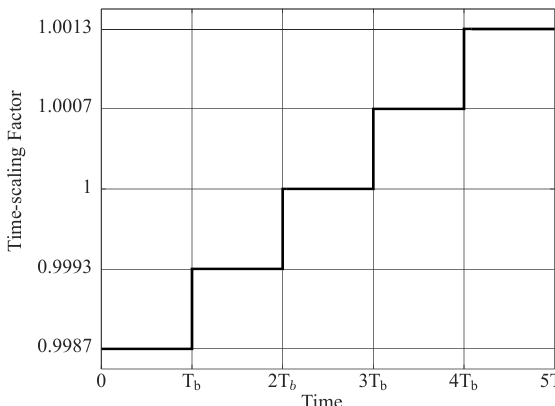
Figure 5. Step-like time-varying time-scaling function. The relative velocity during each OFDM block remains constant and it is changing from one block to the next. The vector of the relative velocity is v r = [ 2, 1,0,1,2 ] m/s. The OFDM block duration is T b = 1.9 s. − −